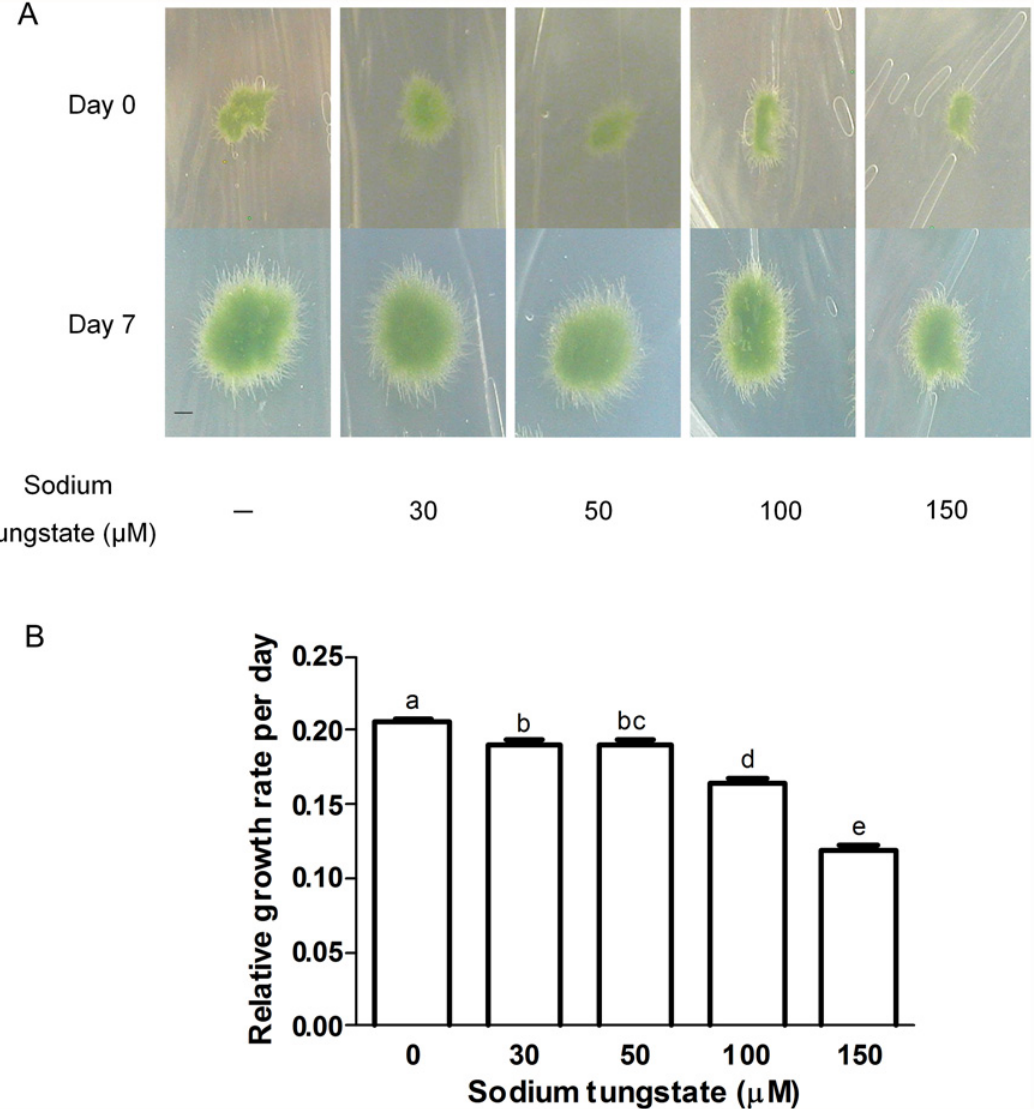
Fig 2. Effect of sodium tungstate on P. patens protonema growth. A) Plants grew for seven days on simple Knop medium or on media supplemented with the indicated concentrations of sodium tungstate. Pictures were taken at the beginning and end of the experiment, Day 0 and Day 7, respectively. Scale bar = 3 mm B) Plant relative growth rate was measured according to 52. ( ln a f — ln a 0 )t -1 where a f and a 0 are the plant area at day 7 and at day 0, respectively. t is the time growth in days = 7. Data are mean of three independent experiments. Data were analyzed by one-way ANOVA and Tukey´s multiple comparison test ( n = 84). Different letters indicate a statistically significant difference ( P < 0.05). Error bars denote